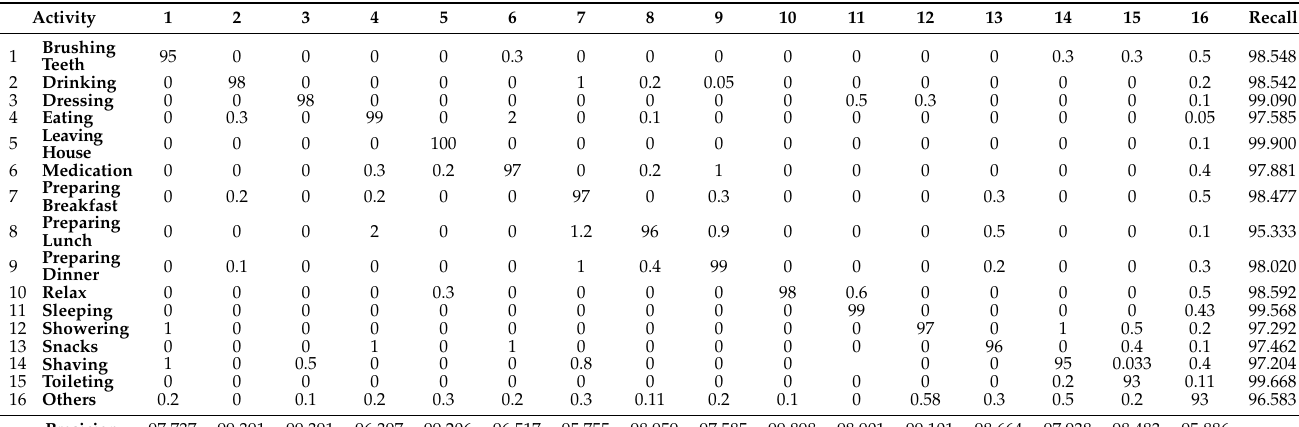
Table 4. Confusion matrix for House-C.